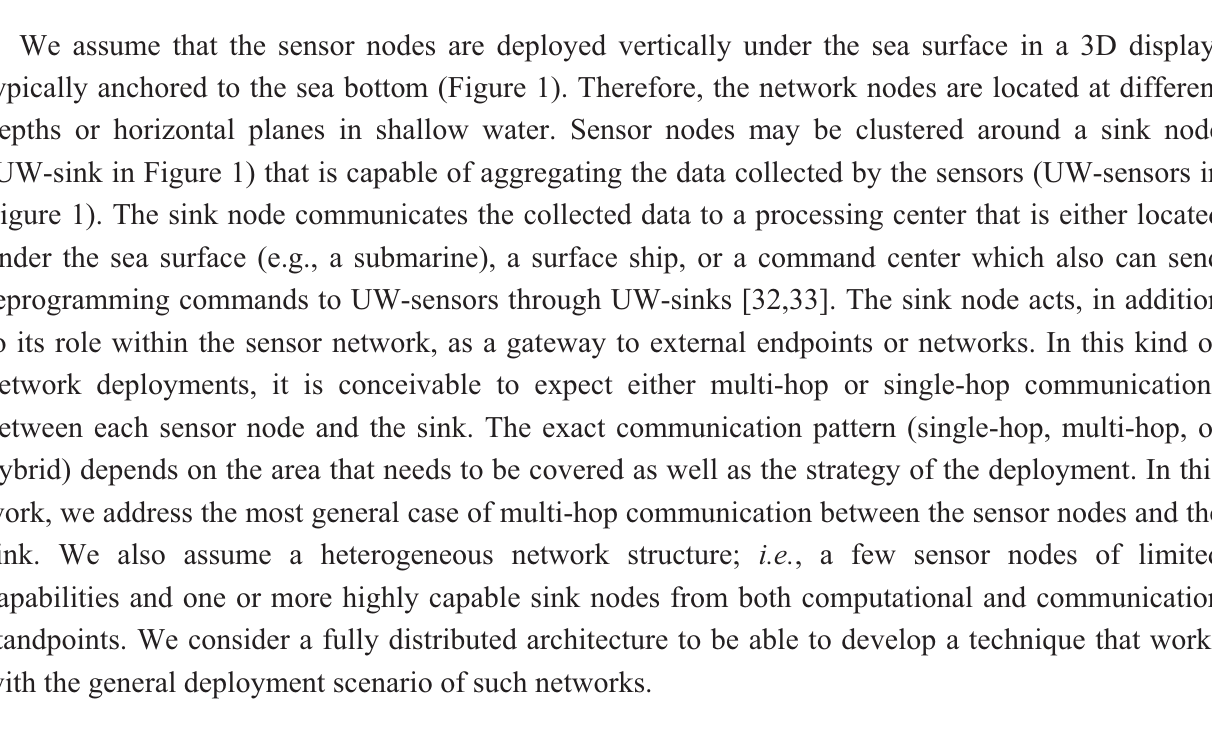
Figure 1. Underwater acoustic sensor network